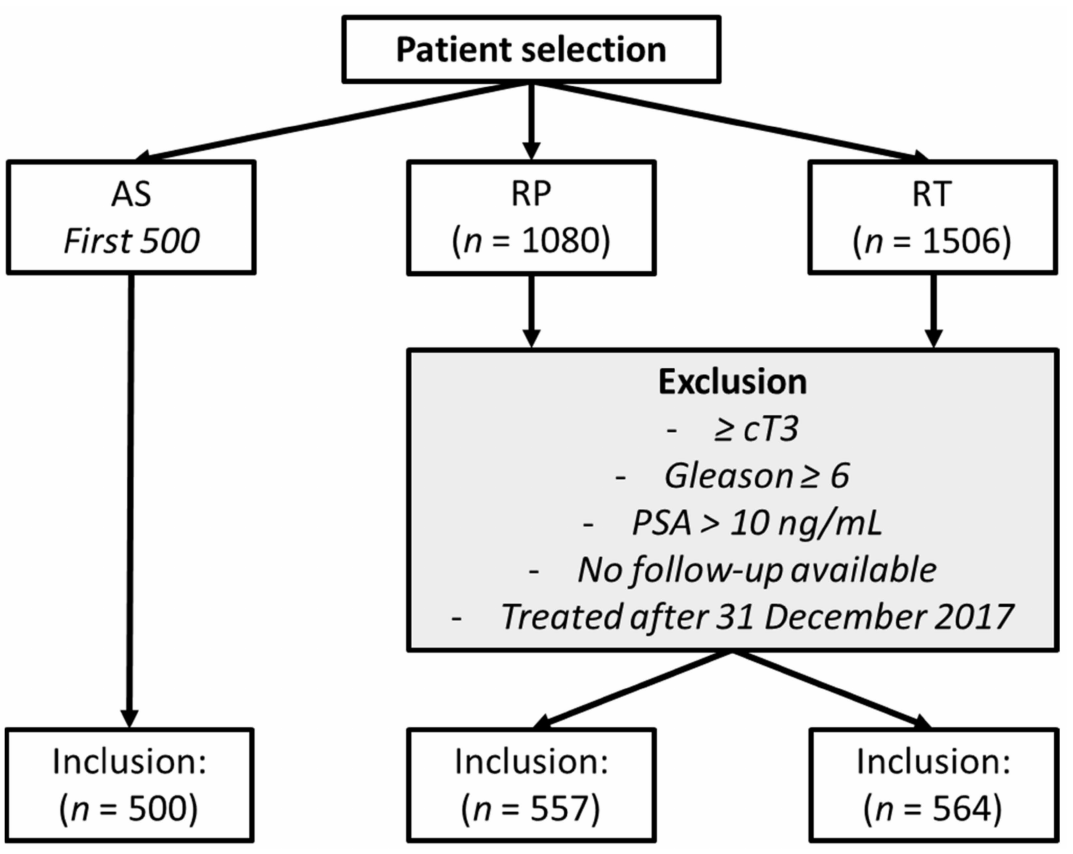
Figure 1. Patient flowchart. Active Surveillance (AS); prostatectomy (RP); radiation therapy (RT); prostate-specific antigen